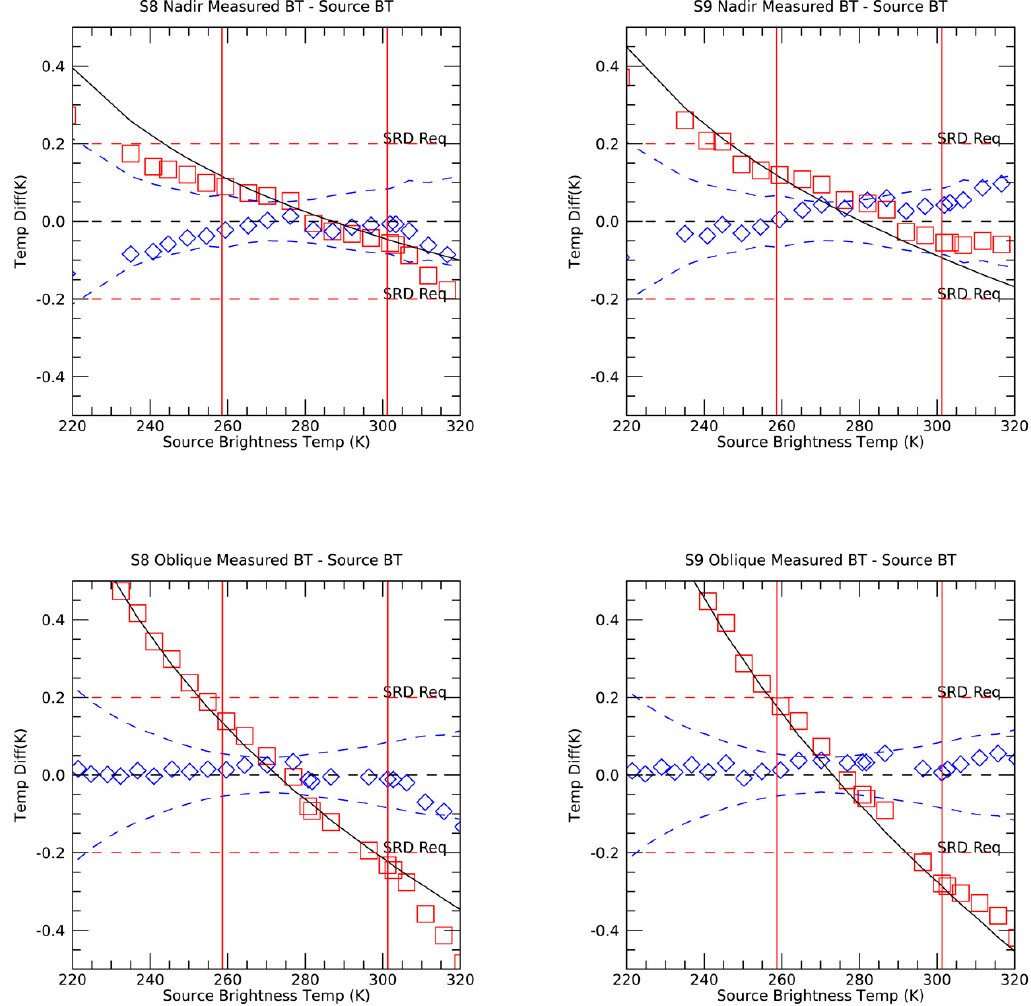
Figure 15. SLSTR-A S8 and S9 BT differences after adjusting for the stray light error. ☐ Uncorrected; Corrected data; — Stray-Light Model ; - - Combined uncertainty (k = 3).